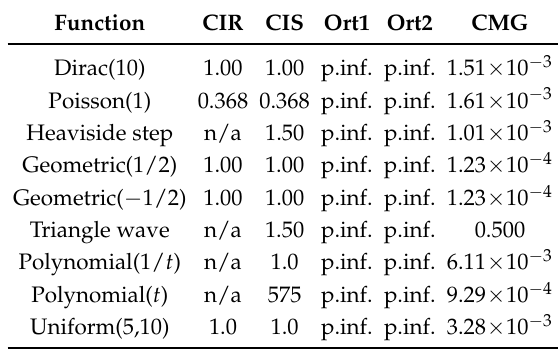
Table 8. Errors for various test functions ( N = 256, T max = 512, a =